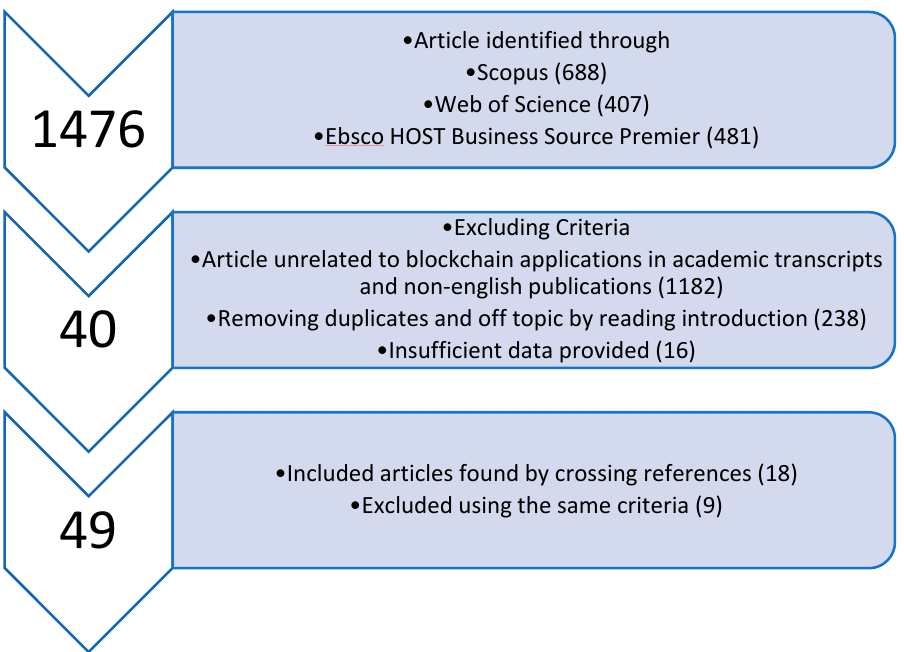
Figure 1. Literature Review Strategy.